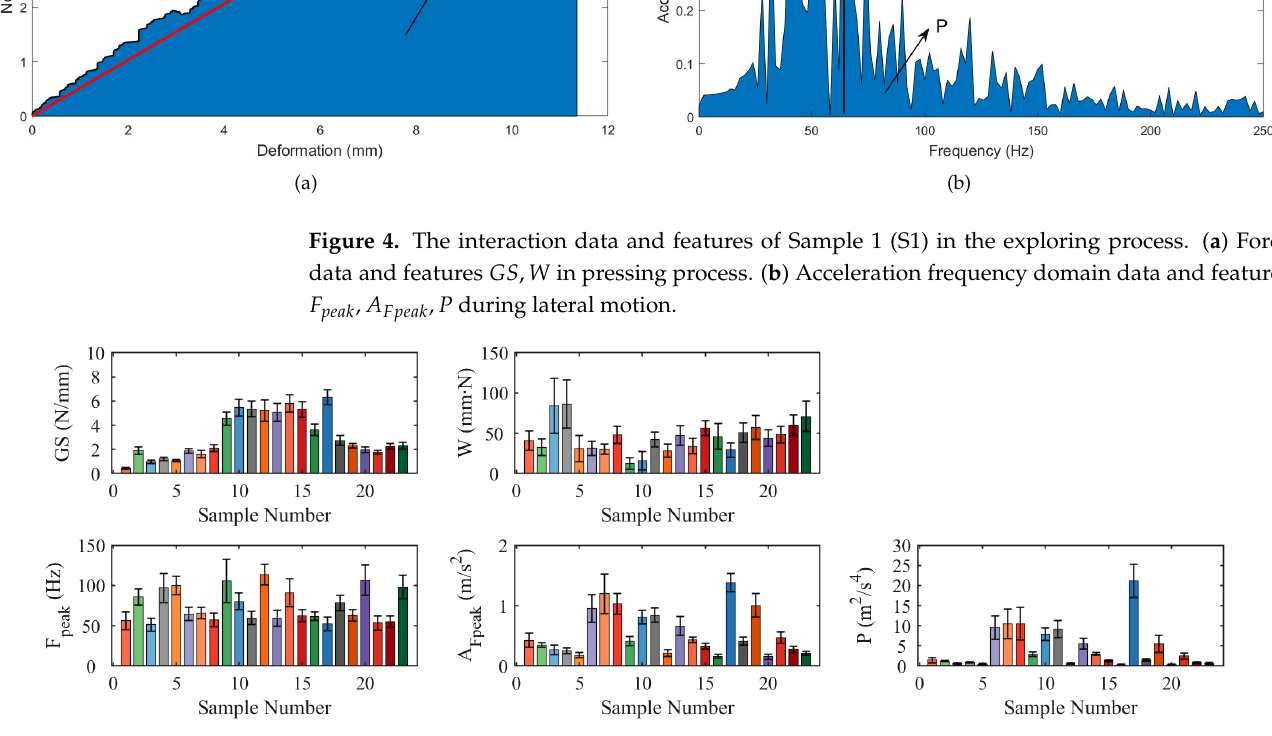
Figure 5. The means and standard deviations of twenty-three samples’